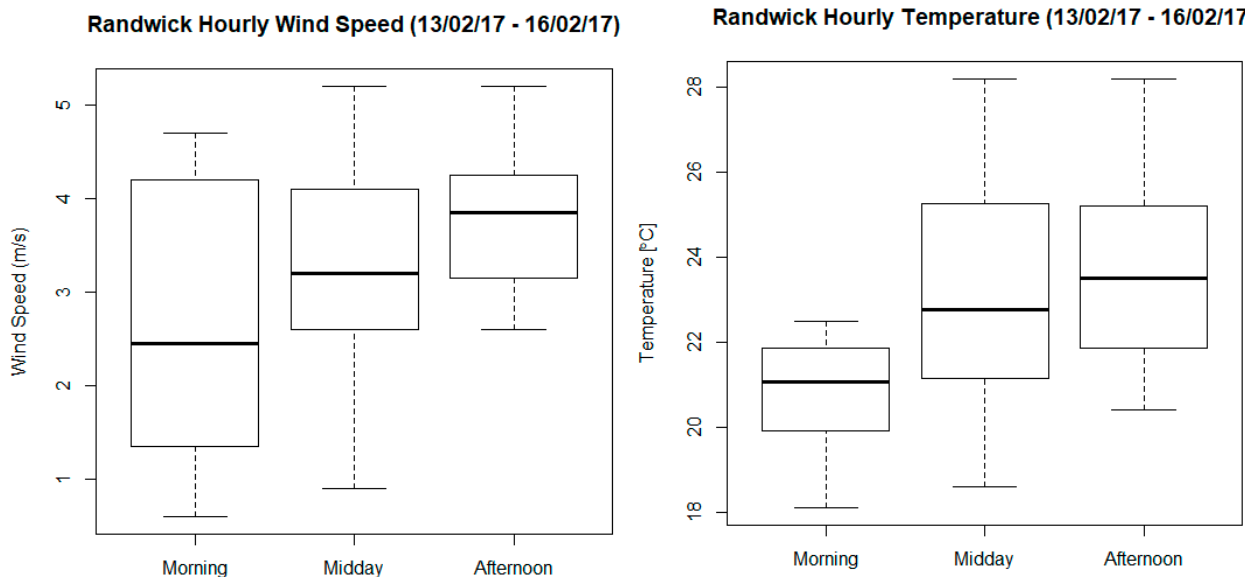
Figure A2. ( left ) Hourly wind speed (m / s) and ( right ) hourly air temperature ( ◦ C) measured at the Randwick Air Quality Monitoring site (33 ◦ 56’ 00”S, 151 ◦ 14’ 31”E). Data subsetted into morning (07:00–10:00), midday (10:00–16:00), and afternoon (16:00–19:00) sections to align with temporal study subsets. The black lines are the median values, and the box includes the upper and lower quartiles (inter-quartile range). The whiskers extend to 1.5 × the inter-quartile range. For clarity, outliers were removed from the figure if they exceeded beyond the edge of the whiskers. Data retrieved from NSW OEH, https: // www.environment.nsw.gov.au / AQMS /